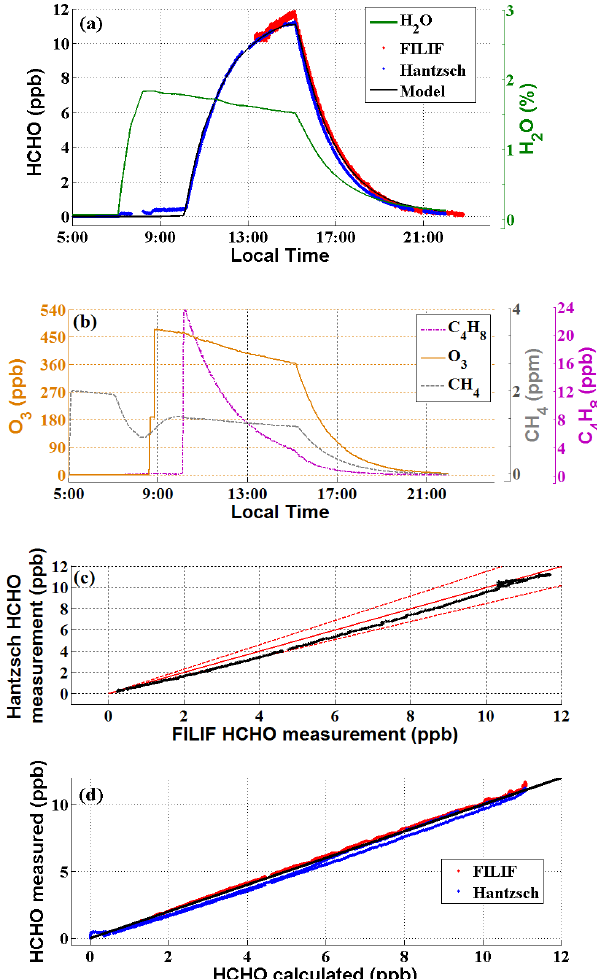
Figure 4. (a) Time series of measured and calculated HCHO mix- ing ratios and H 2 O during day 4. (b) Time series of C 4 H 8 , ozone, CH 4 . (c) Comparison between HCHO measurements. Error bars represent 3 σ precision. Lines represent 1 : 1 agreement and ± 15% FILIF measurements. (d) Measurement/model comparison, with the line showing 1 : 1 agreement.